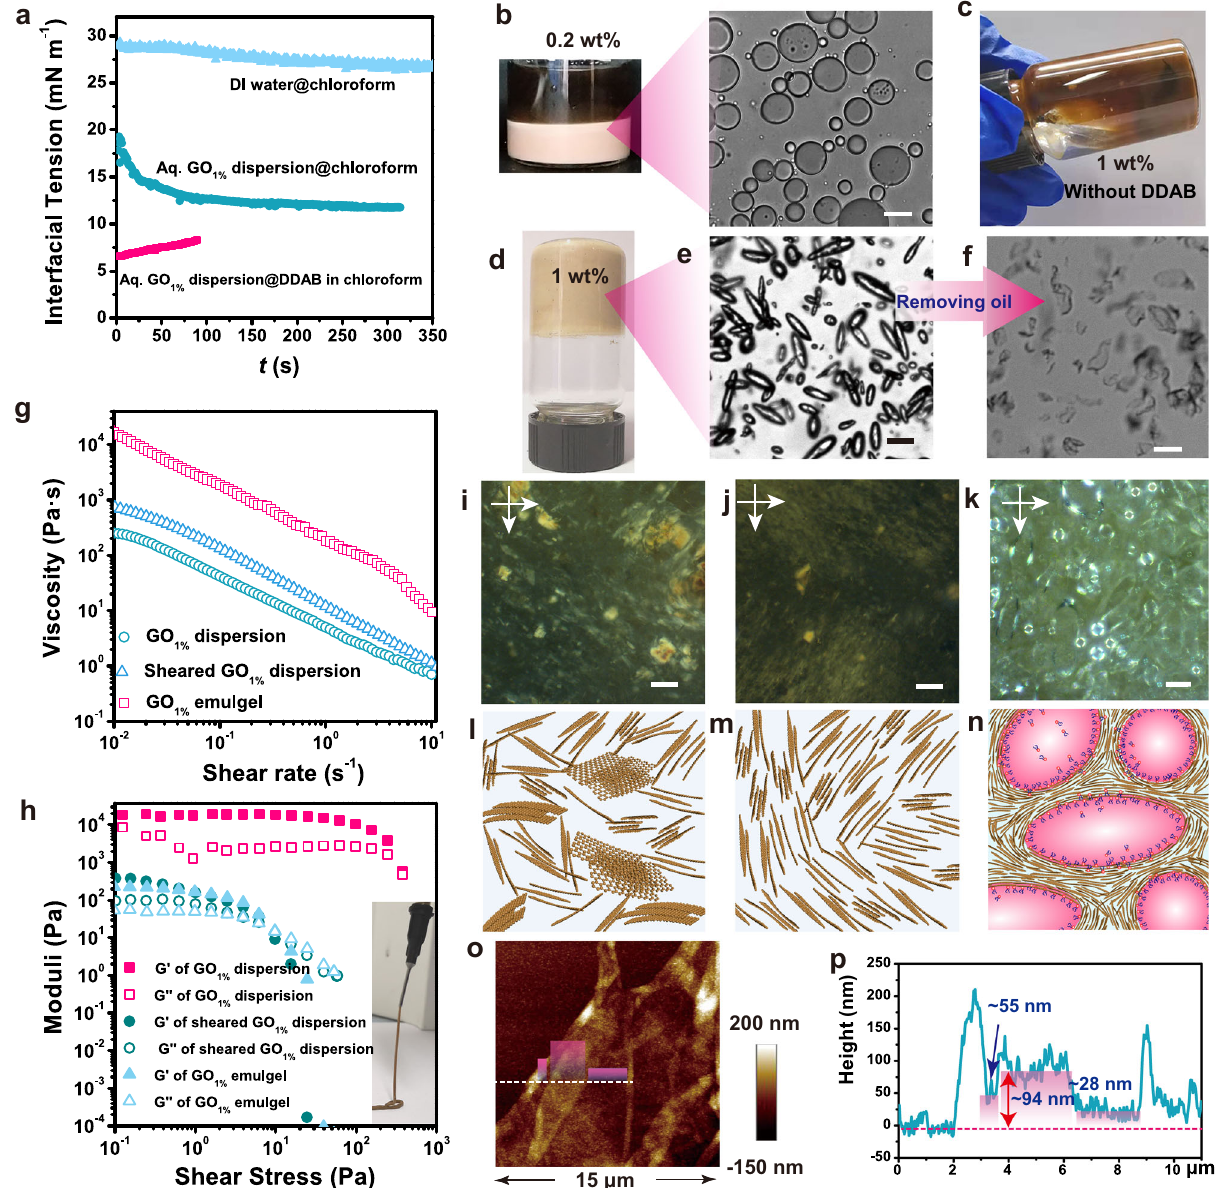
Fig. 2 Formation of interfacial jamming stabilized GO/DDAB emulgel inks. a Time evolution of interfacial tension of different oil-water systems, including deionized (DI) water@chloroform, aqueous (aq.) GO 1.0% dispersion@chloroform, or aq. GO 1.0% dispersion@chloroform DDAB solution. b Optical and optical microscope (OM) images of GO 0.2% /Idobenzene (IB) emulsion. c Image of IB and aq. GO 1.0% solution mixtures that fail in emulsi fi cation. d Image of GO 1.0% /DDAB-IB emulsion. e , f OM images of GO 1.0% /DDAB-IB emulsion droplets before ( e ) and after removing the oil phase ( f ). Continuous membranes outside droplets are displayed. g , h Apparent viscosity as a function of shear rate ( g ) and shear storage modulus as a function of shear stress for GO 1.0% dispersion and GO 1.0% /DDAB-IB. G ’ and G ” represent the storage modulus and loss modulus, respectively. Inset in ( h ) is a photograph of sustainable GO 1.0% /DDAB-IB fi laments after extrusion. i – n Polarized optical microscopy (POM) images of GO texture ( i – k ) and schematic illustration of GO packing ( l – n ) in GO 1.0% dispersion with (I, l )/without shearing ( j , m ) and GO 1.0% /DDAB-IB emulgel ( k , n ). o Atomic force microscope (AFM) image of the interfacial membrane that formed at the interface of chloroform DDAB solution (0.1 wt%) and aq. GO solution (0.05 wt%) and p the height pro fi le. The heights of 28 nm, 55 nm, 94 nm correspond to one, two, and three folded layers of membrane. Scale bars, 20 μ m ( b , e , f , k ), 100 μ m ( I , j